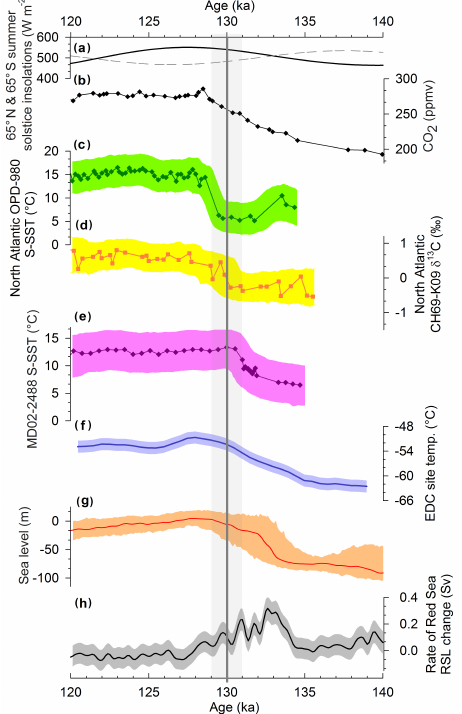
Figure 1. (a) 65 ◦ N (black) and 65 ◦ S (grey) summer insolation (Laskar et al., 2004). (b) EDC (EPICA Dome C) ice core CO 2 con- centration (Schneider et al., 2013) (black). (c) North Atlantic core ODP-980 summer-SST reconstruction (Oppo et al., 2006) (green) and associated 2 σ uncertainty envelope (Capron et al., 2014) (light green). (d) North Atlantic core CH69-K09 δ 13 C record (Govin et al., 2012) and 2 σ uncertainty envelope (this study; see details on the methodology in Capron et al., 2014). (e) Southern Ocean core MD02-2488 summer-SST reconstruction (Govin et al., 2012) (pink) and 2 σ uncertainty envelope (Capron et al., 2014) (light pink). (f) EDC surface temperature reconstruction (dark blue) and associated 1.5 ◦ C uncertainty envelope (Masson-Delmotte et al., 2011) (light blue). Note that Govin et al. (2015) reports in Table 5 of their pa- per that the Antarctic reconstructed surface temperature (based on EDC δ D) starts increasing at 135.6 ± 2.5ka based on the use of the RAMPFIT software. (g) Red Sea relative sea level (RSL) data (probability maximum, red) with 95% confidence interval (Grant et al., 2012) (orange). (h) Red Sea rate of RSL change (probabil- ity maximum for the first-order time derivative, inSv, black) with 95% confidence interval (Grant et al., 2012) (grey). Note that ice and marine records from (a) to (f) are shown on the AICC2012 ice core chronology (Bazin et al., 2013; Capron et al., 2014; Veres et al., 2013), while the Red Sea records (g, h) are displayed on their original age scale, which is independent of the AICC2012 ice core chronology (see Grant et al., 2012, for details) The grey vertical line marks 130ka. The grey band highlights the 129–131ka time inter- val that has been considered for the construction of the 130ka data- based time slice for surface temperature (see Capron et al., 2014, for details on the